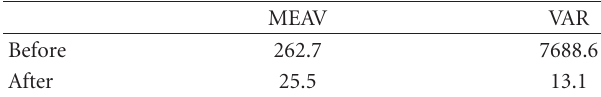
Table 4: Mean and variance of the data lengths before and after applying the time-series reduction technique. MEAV VAR Before 262.7 7688.6 25.5 13.1